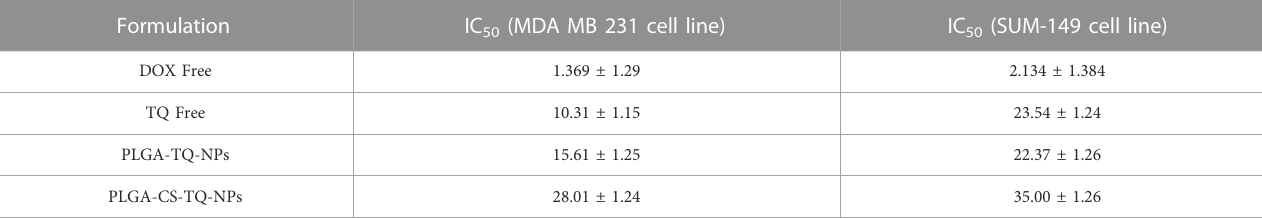
TABLE 5 Represents the IC 50 of PLGA NPs with and without CS coating against MDA-MB 231 and SUM 143 TNBC cell line treated for 72